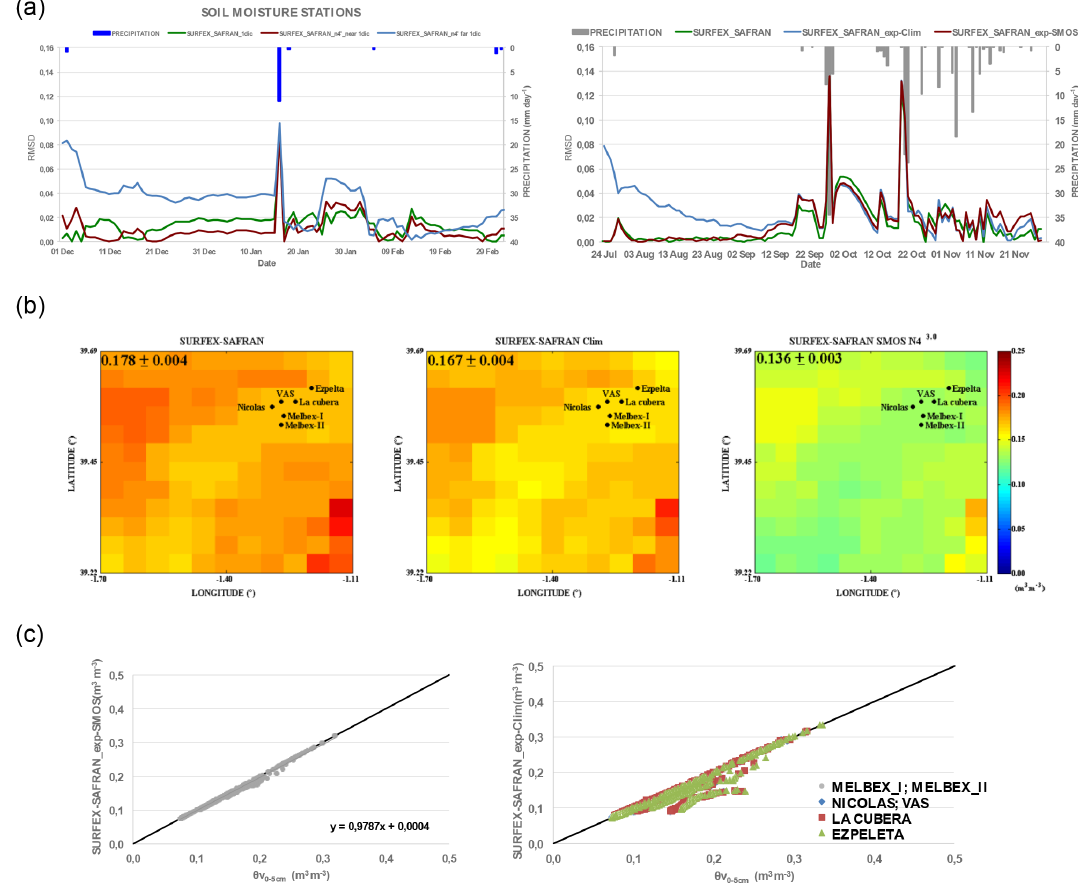
Figure 10. (a) RMSD for the daily mean SSM from the three SURFEX (ISBA) simulations with perturbed initial SSM scenarios (details in Sect. 4.3.2). (b) spatial distribution of mean SSM for the winter simulation (left-hand side, a ) for the three simulations. (c) scatter plot depicting the comparison between in situ SSM observations and SURFEX–SAFRAN–SMOSL4 3 . 0 simulations, as a mean over all stations (left) and for each of the stations